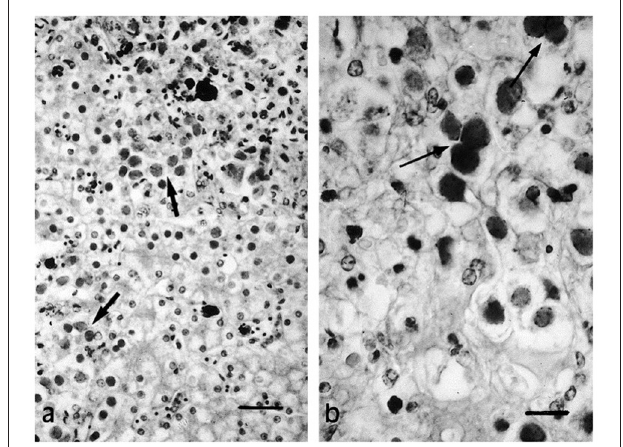
FIGURE 8 | Necrotic foci (a) and syncytial formation (b) in HV infected hepatocytes of a tortoise ( Testudo horsfieldii ). “Adapted from Hepatitis Associated with Herpes Viral Infection in the Tortoise ( Testudo horsfieldii )” by Hervás et al. (112). Copyright 2021 by John Wiley and Sons. Reprinted with permission.